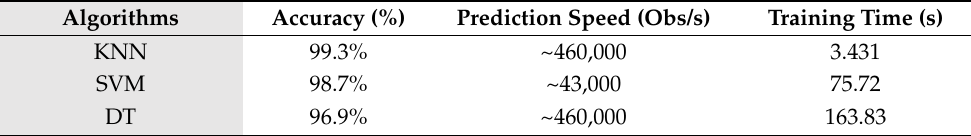
Table 7. Performance of algorithms for human breathing experiments